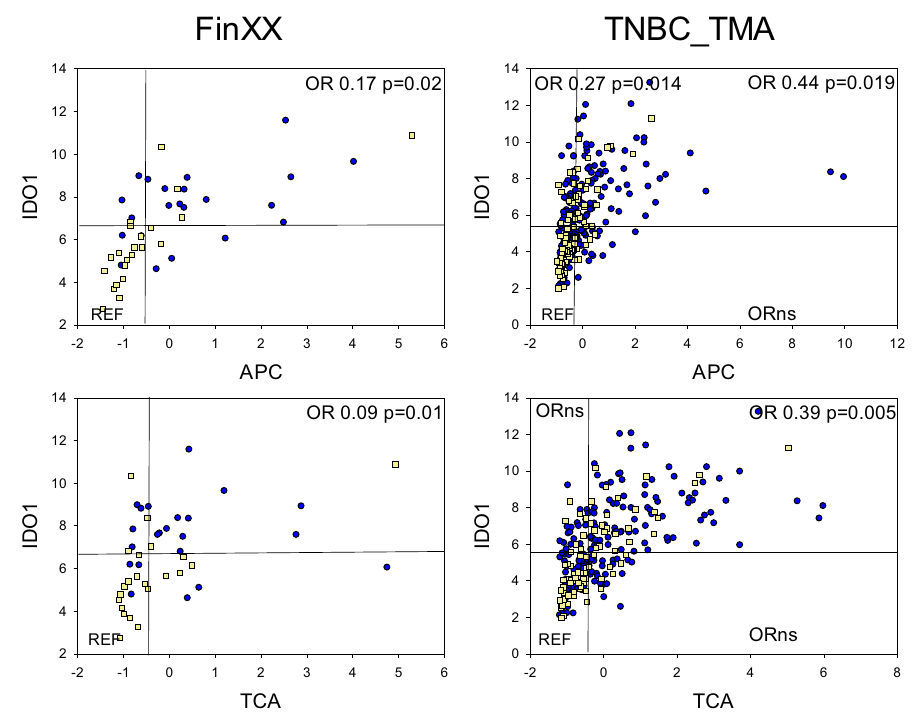
Fig. 4 | Recurrence in FinXX (left panel) and Mayo Clinic TNBC_TMA (right panel) cohorts as a function of IDO1 protein abundance and APC or TCA eigenprotein scores. As in Fig. 3, each dot or square represents an individual tumor, including tumors that recurred (yellow squares), and tumors that did not recur(bluecircles).NumericalvaluesforAPCorTCAeigenproteinscoresaregiven on the X axis, and normalized log2 counts for IDO1 protein are given on the Y axis. ORs were calculated for 5-year recurrence. Reference lines indicate the median